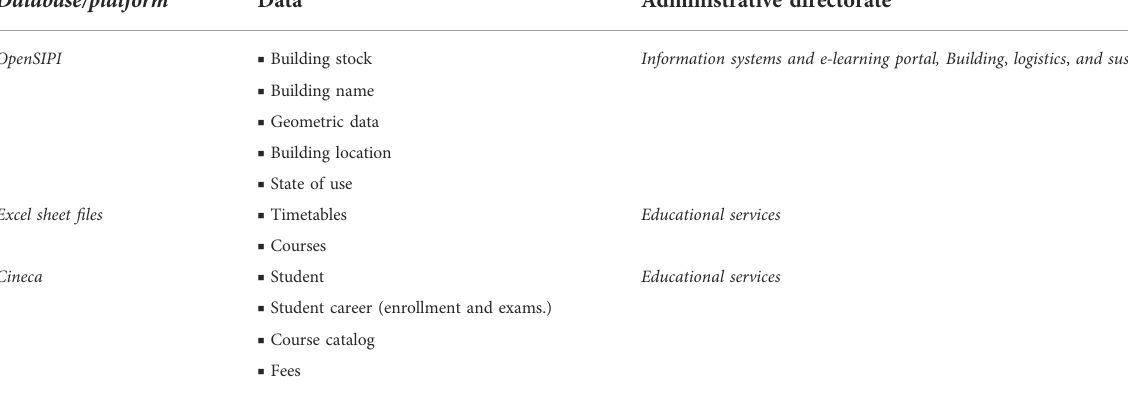
TABLE 1 Existent databases or platforms, related data, and involved directorates. Database/platform